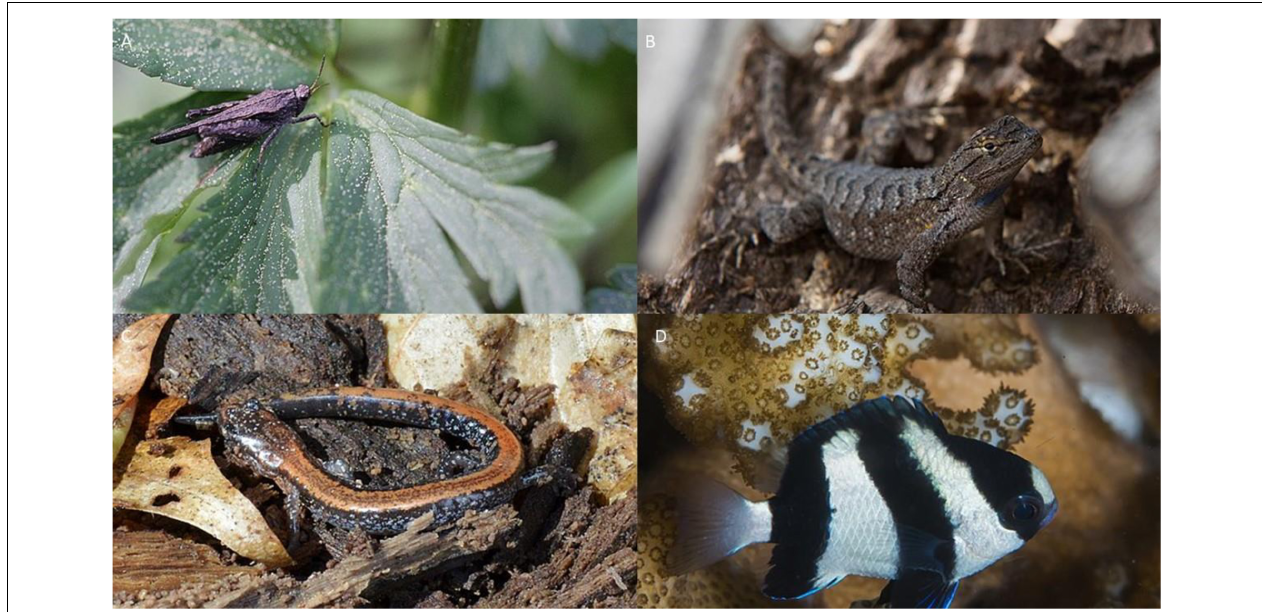
FIGURE 3 | Animals whose coloration are impacted by landscape change. (A) Pygmy grasshopper ( Tetrix subulata ) by Hedwig Storch. Melanic morphs of the pygmy grasshopper are favored over non-melanic morphs after a fire event. (B) Western fence lizard ( Sceloporus occidentalis ) in Joshua Tree National Park by Hannah Schwalbe. The western fence lizard has been shown to perch on burnt twigs after a fire event to match its background better. (C) Eastern red-backed salamander ( Plethodon cinereus ) in Mississauga, Ontario by Ryan Hodnett. The striped morph of the eastern red-backed salamander relies on cooler and more moist microclimates that are declining due to forest fragmentation and climate change. (D) Humbug dacyllus ( Dascyllus aruanus ) in Lembeh, Indonesia by Rickard Zerpe. The dascyllus is one species of reef-dwelling fish that is experiencing greater predation rates due to coral bleaching.